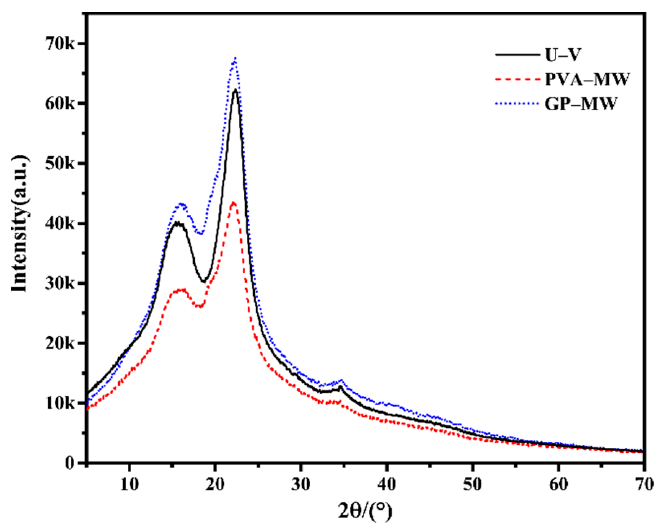
Figure 9. XRD of untreated veneer, PVA, and Gr/PVA impregnated modified veneers.